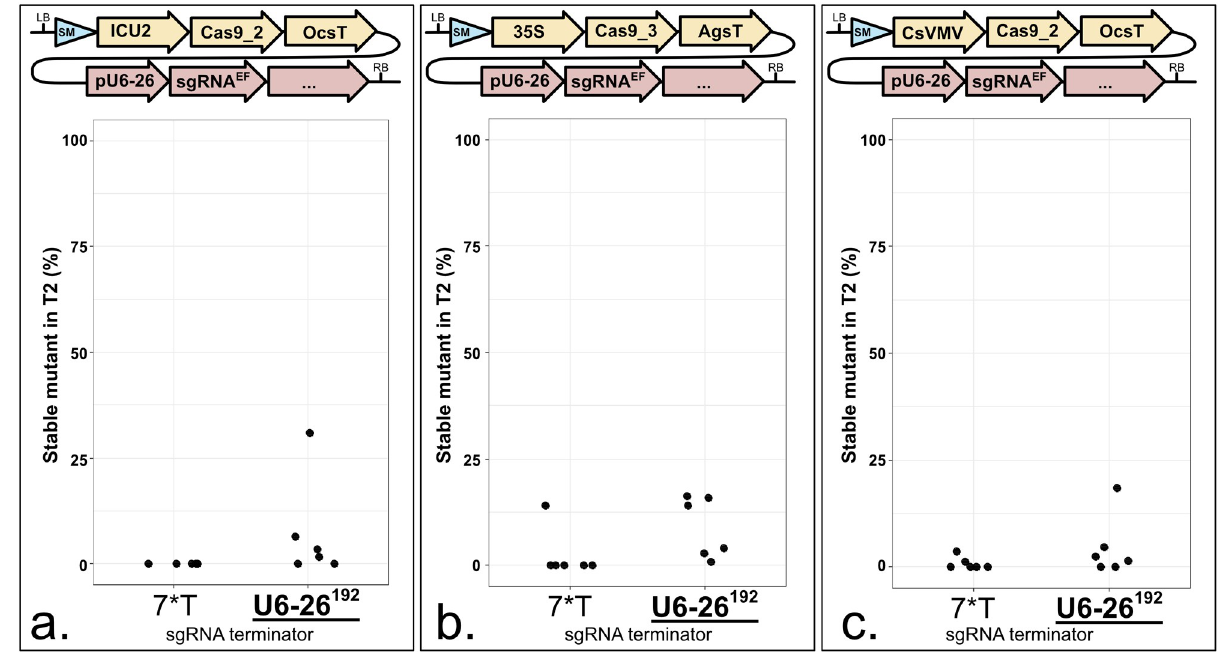
Fig 6. The sgRNA expression regulated by an authentic 3’ regulatory sequence of U6-26 produces greater mutation rates. a. to c. Each panel represents a terminator comparison in the same context. Terminators can be compared within each panel, not from one panel to another. The modules were assembled into pAGM4723 and transformed into Col-0 via Agrobacterium tumefaciens strain GV3101. LB: Left Border. SM: Selectable Marker ( Glufosinate resistance gene). ICU2: 625 bp of the At5g67100 promoter. 35S: 426 bp of the 35S promoter from Cauliflower Mosaic Virus. CsVMV: 517 bp of a promoter from Cassava Vein Mosaic virus. Cas9_2: Fauser et al ., 2014 [13]. Cas9_3: Li et al ., 2013 [25]. OcsT: 714 bp of the Agrobacterium tumefaciens octopine synthase terminator. AgsT: 410 bp of the Agrobacterium tumefaciens agropine synthase terminator. U6-26p: 205 bp of the At3g13855 promoter. sgRNA EF : “extension-flip” sgRNA. U6-26T: 7 or 192 bp of the At3g13855 terminator. RB: Right Border. a. Five lines were tested for U6-26 7 instead of six. The sgRNA targets ADH1 . CRISPR activity measured in % of homozygous or biallelic stable mutants in the second generation after transformation (T2). Each dot represents an independent T2 family. Bold and underlined: Most active construct(s) for each panel.